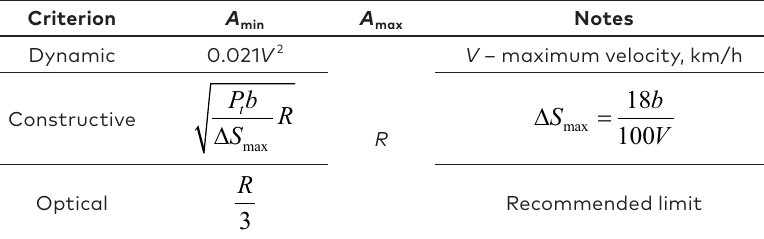
Table 1. Limitations to the clothoid scale parameter